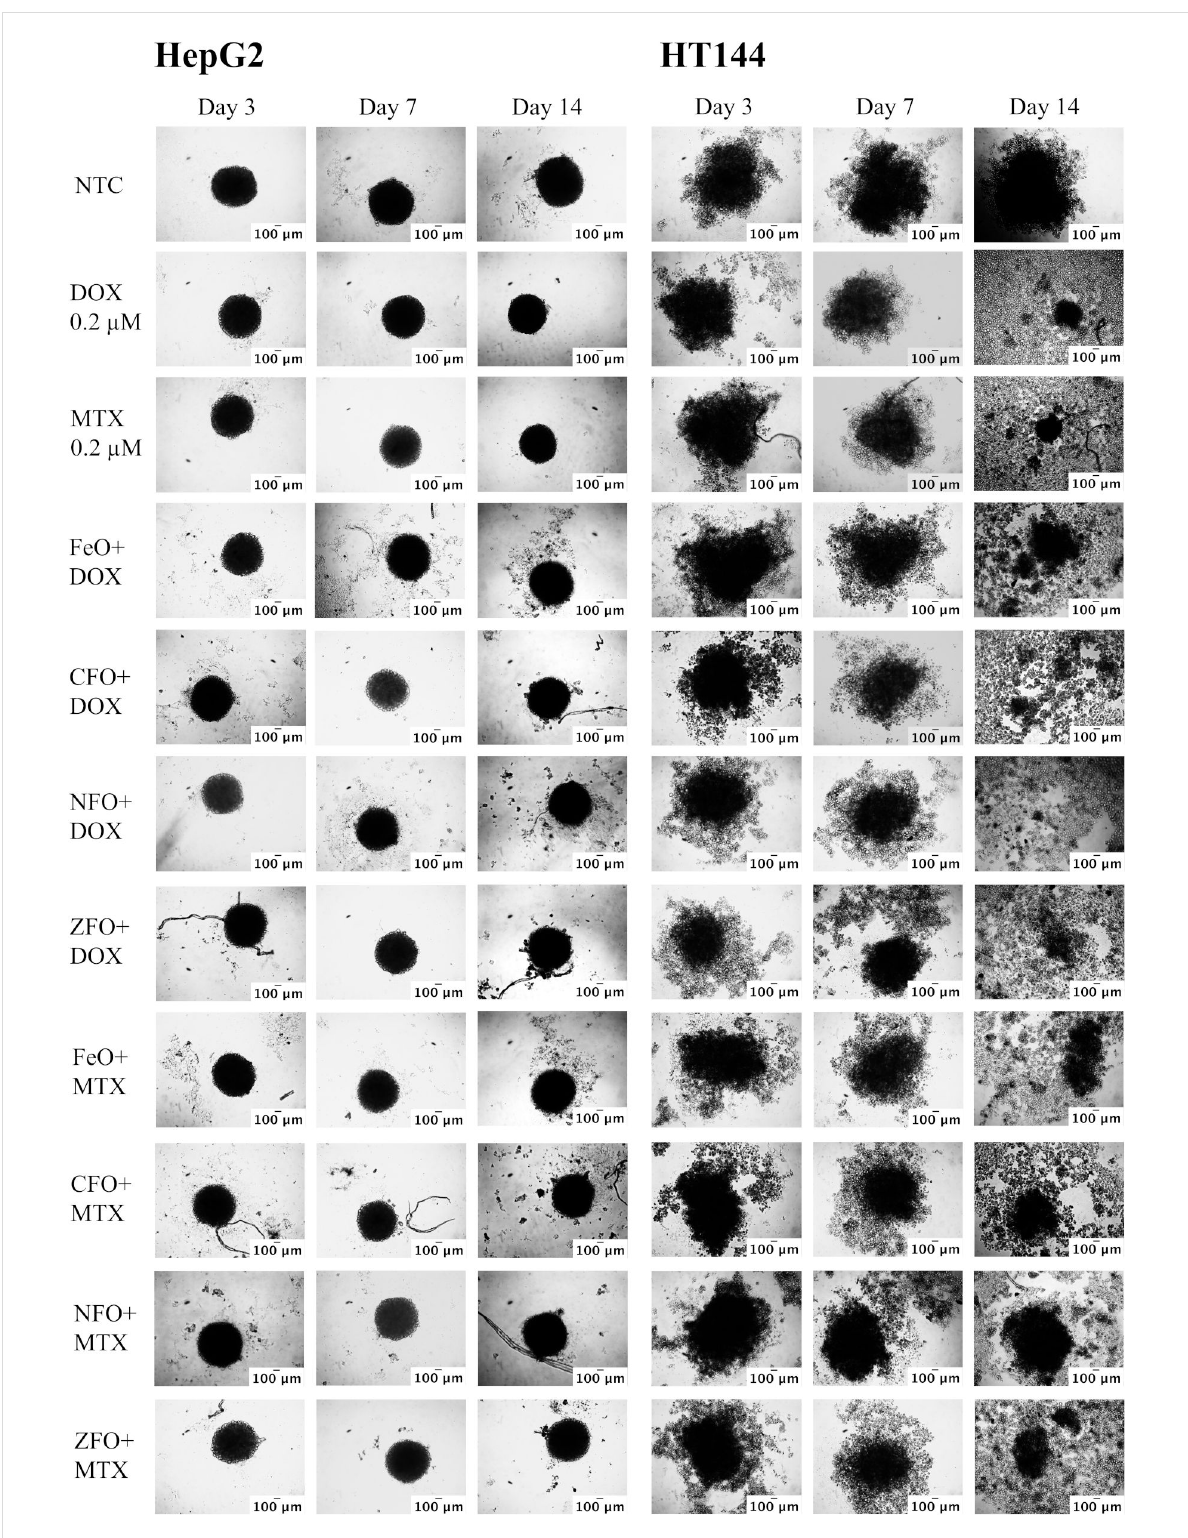
Figure 8: Microscopy images (magnification = 100×, scale bar = 100 µm) of HepG2 and HT144 3D spheroids grown for three days and then treated with drug-loaded (DOX and MTX) MFe 2 O 4 (M = Fe, Co, Ni, Zn) NPs at 5 µg/mL for 14 days. Controls included free drugs (DOX and MTX, 0.2 µM each) and NTC. The medium was replenished after regular intervals and photographs were taken after three, seven, and fourteen days to observe changes in spheroid